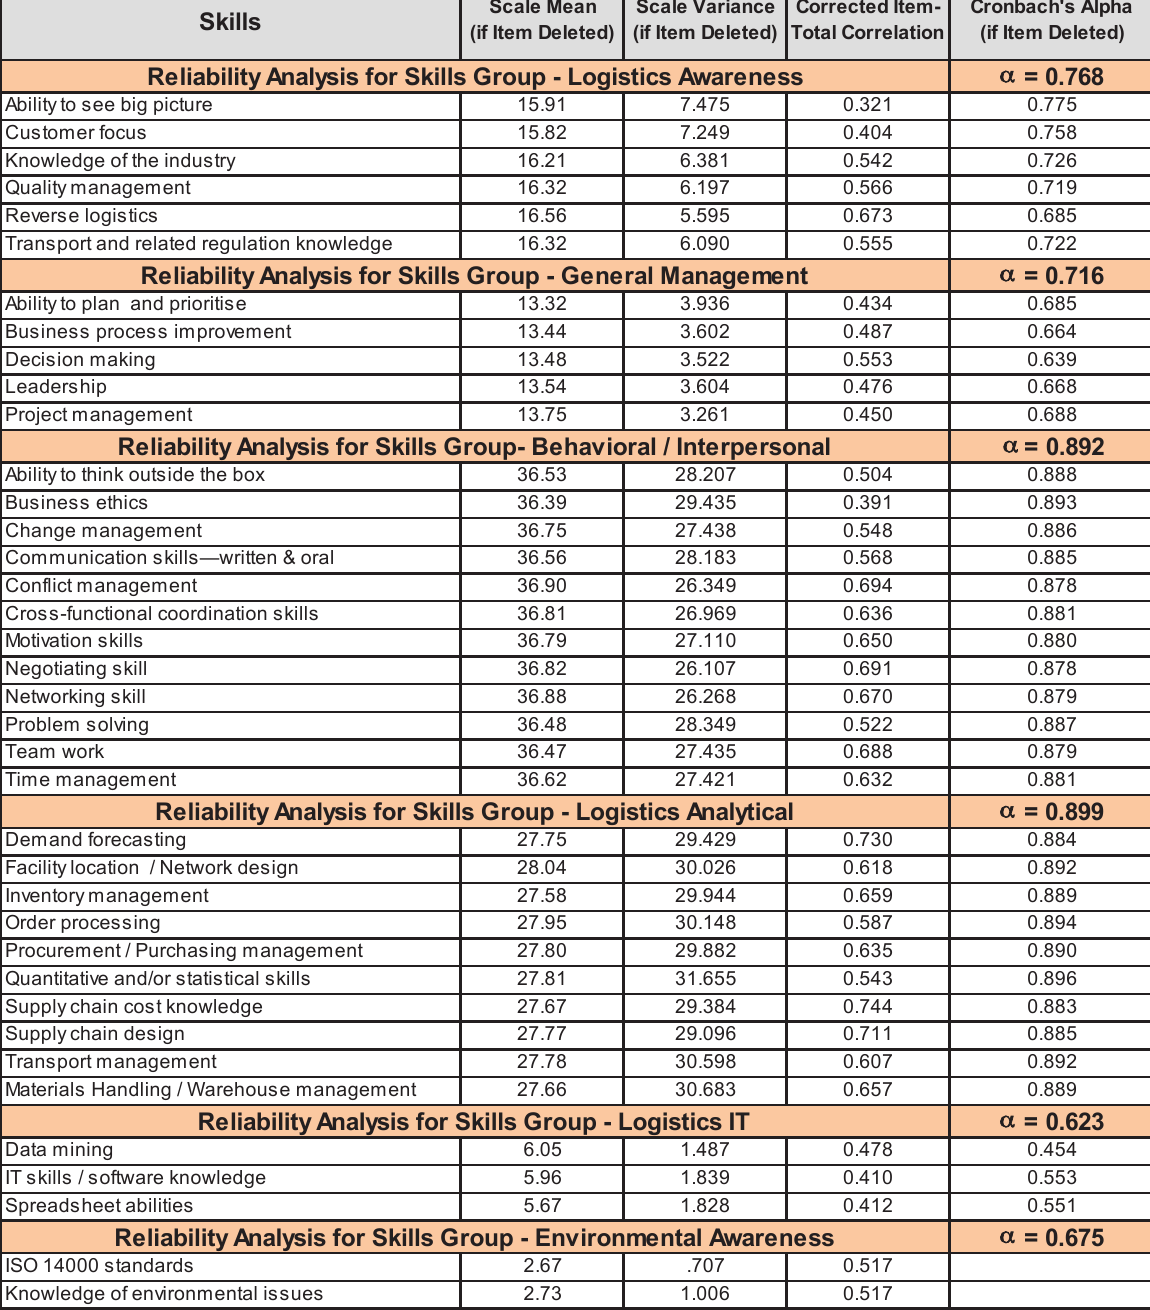
Table 3: Reliability analysis of the various skills groups Scale Skills